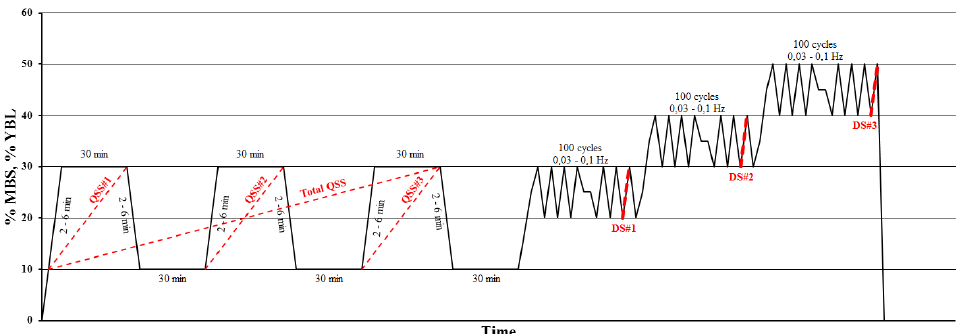
Figure 1. Test routine according to ISO 18692:2013 [7].